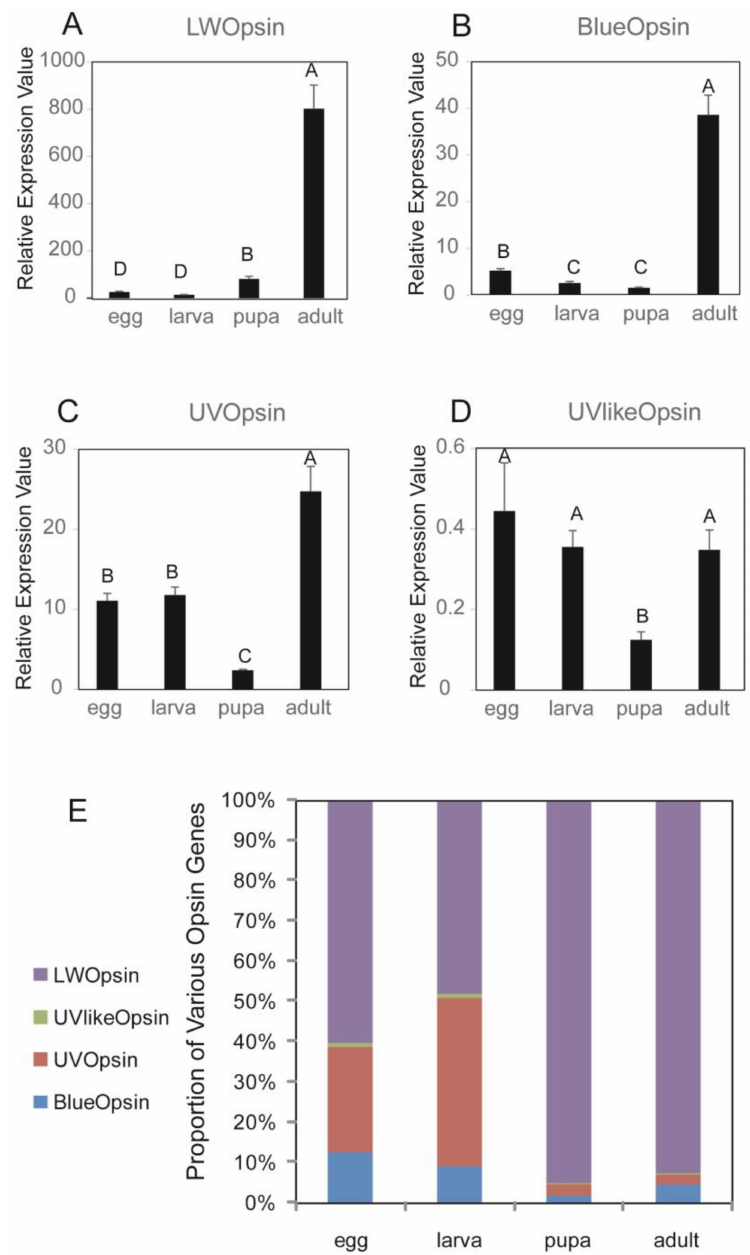
Figure 3. Development stages-dependent expression levels and ratios of the four opsin genes in D. punctatus . ( A ) expression levels of DpunOpsin LW ; ( B ) expression levels of DpunOpsin blue ; ( C ) expression levels of DpunOpsin UV ; ( D ) expression levels of DpunOpsin UV = like ; ( E ) ratios of various opsins at each developmental stage. Real-time PCR was performed using various tissue samples of Dendrolimus punctatus , and the expression values were normalized to that of β -actin in A-D. Three replications were performed, and the expression data were shown as mean ± SE in A-D and mean value in E. The letters above each bar of A-D indicate significant di ff erences according to a Tukey’ honestly significant di ff erence (HSD) test ( p <